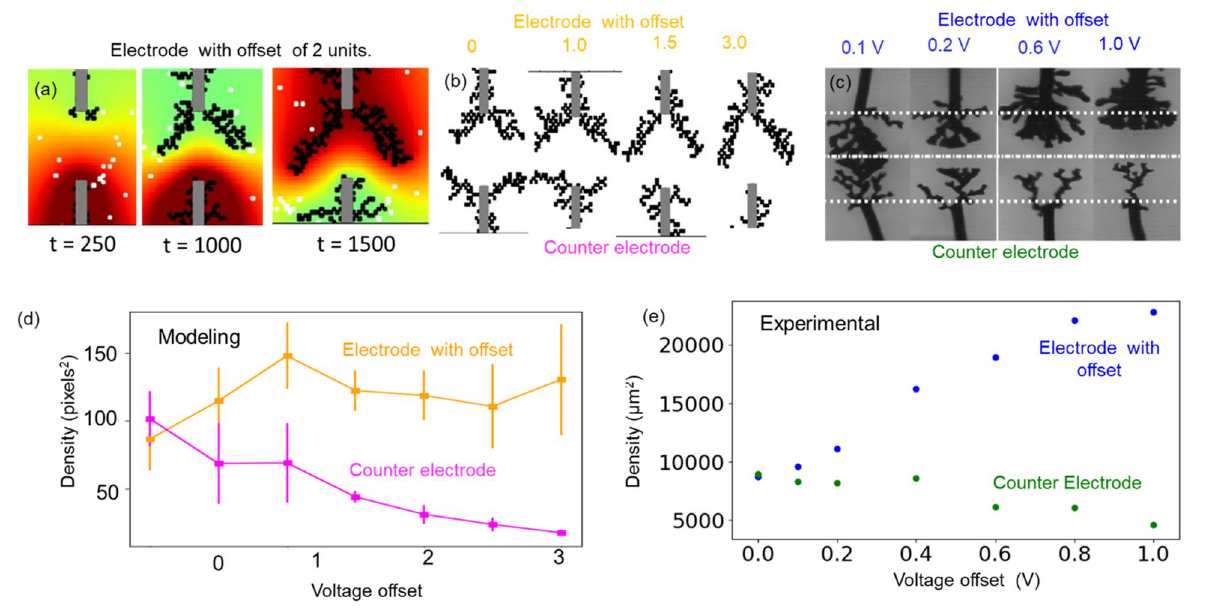
Figure 3. ( a ) The growth process of dendrites along with spatio-temporal map for voltage offset of 2 voltage units, demonstrating higher attraction of particles towards the electrode with offset. ( b ) Modeling images of morphologies for voltage offset of 0–3 voltage units. ( c ) Experimental images of dendrites morphologies at voltage offsets of 0.1–1 V 14 . ( e ) Dendrite density comparison for the modeling images for the electrode with offset (shown in orange) and counter electrode (shown in magenta). ( e ) Dendrite density comparison for the experimental images for the electrode with offset (shown in blue) and counter electrode (shown in